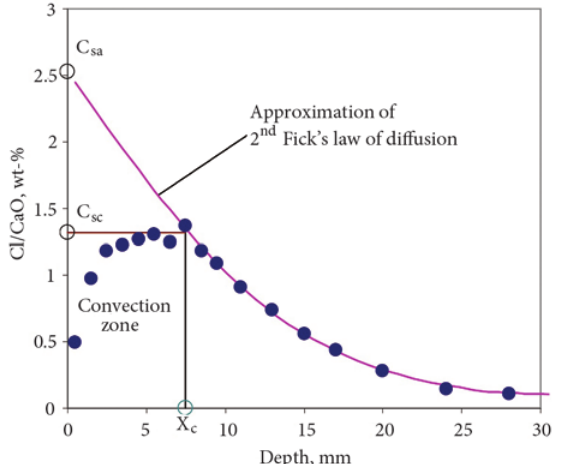
fig. 1. Chloride profile in the concrete cover (Nilsson 2000)